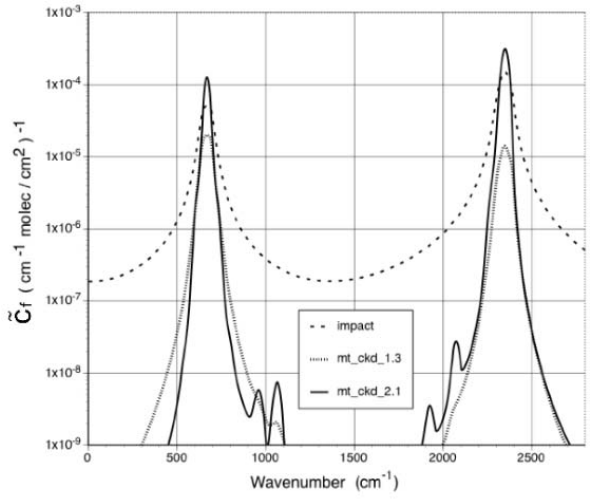
Fig. 14. Plots of LBLRTM CO 2 continuum models: The dashed line is the continuum from the impact approximation (assumes col- lisions occur instantaneously). The dotted line is the CO 2 con- tinuum in MT CKD v1.3 based on an effective chi factor. The solid line is the MT CKD v2.1 continuum based on first order line coupling with parameters from Niro et al. (2005). Note that the CO 2 continuum did not change between MT CKD v2.1 and MT CKD v2.4).